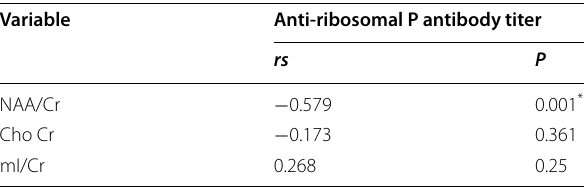
Table 4 Correlation between MR spectroscopic measurements and anti‑ribosomal P antibody titer in group 2 patients ( SLEDAI >